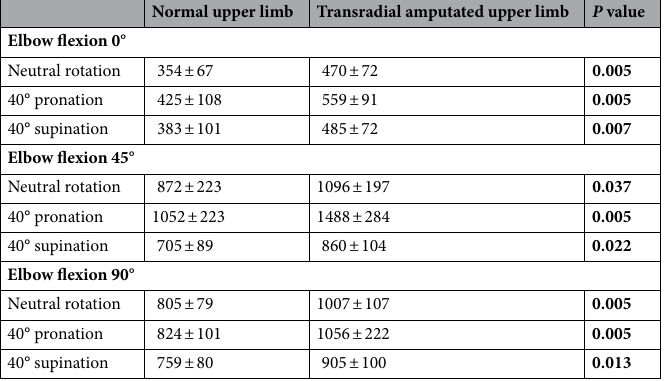
Table 4. Mean pressure of the radiocapitellar joint between normal and transradial amputated upper limbs. Boldface indicates significance. Values are presented as mean ± SD (kPa).